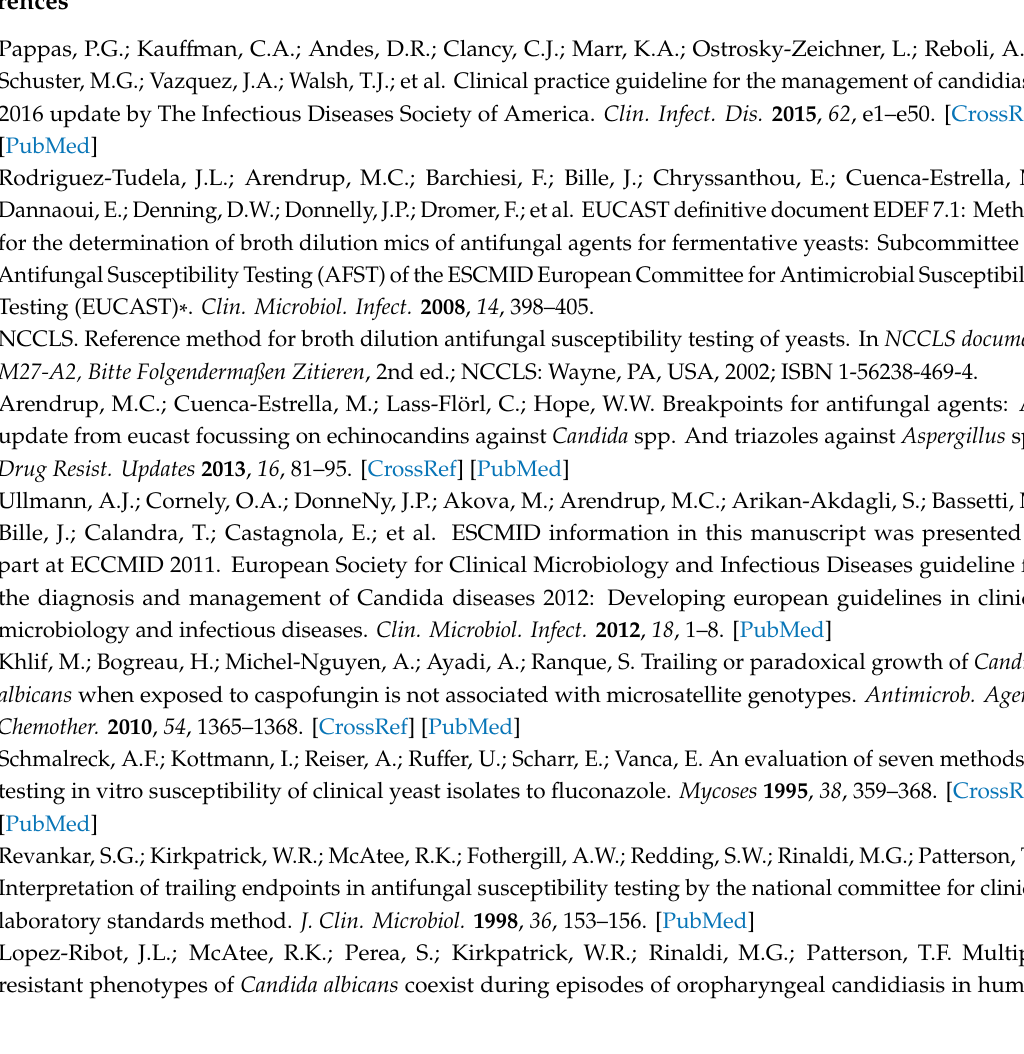
Table S1: Overview on the clinical isolates of C. albicans showing MIC-phenomena determined by EUCAST assay; Figure S1: In vivo e ffi cacy of caspofungin (CAS) in larvae infected with CAS susceptible (A) and CAS resistant (B) strains (no MIC phenomenon); Figure S2: Voriconazole (VOR) treatment increased survival of G. mellonella larvae although lacking statistical significance ( p = 0.48) infected with Candida albicans strain SCH 39 (VOR MIC 0.0078 µ g /